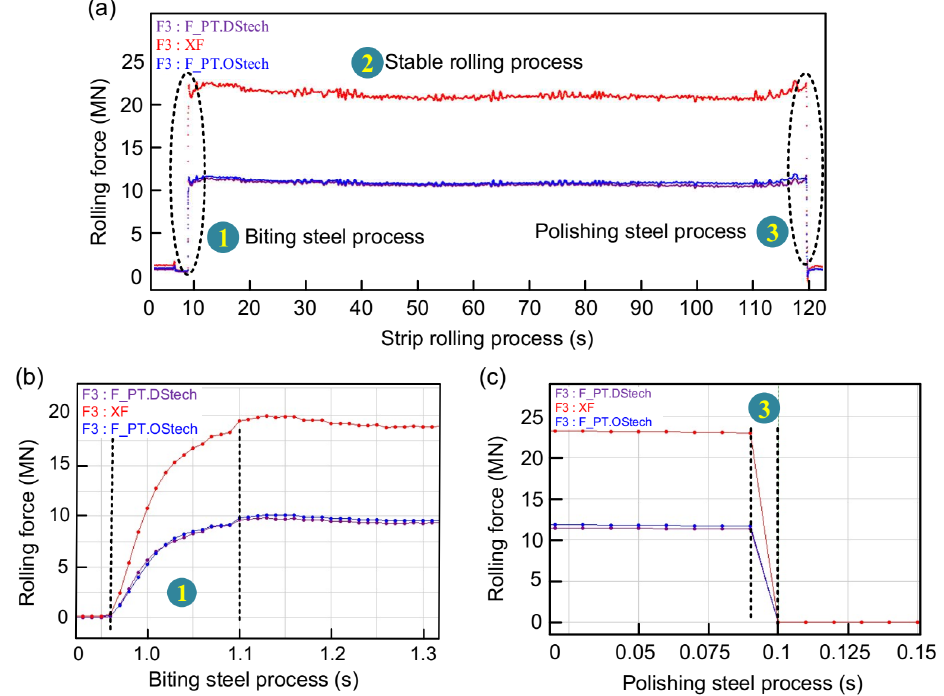
Figure 7. The change in rolling force when the finished product is 3.2 mm: ( a ) total rolling force, ( b ) biting rolling force, and ( c ) polishing rolling force.